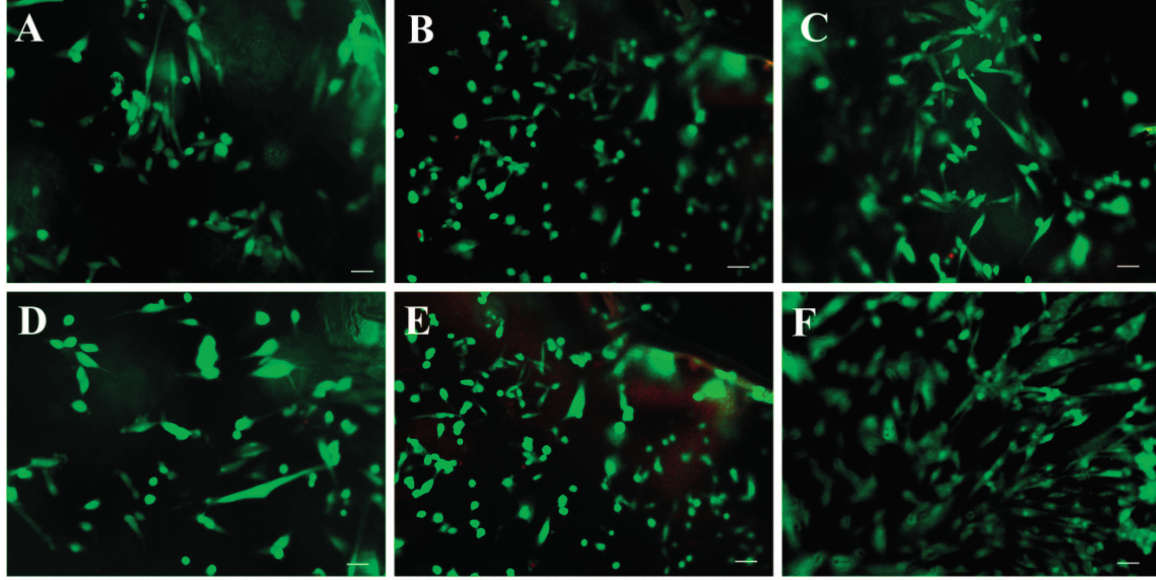
Figure 7. SEM image showing the HDF attachment on the composite scaffold at 24